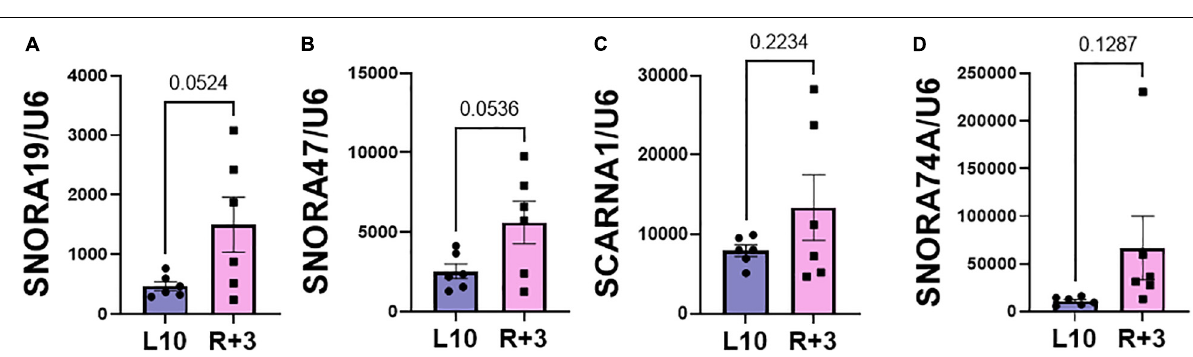
FIGURE 2 | Validation of PBMC snoRNA by RT-qPCR. Validation of differentially expressed snoRNAs in the RNA from PB mononuclear cells (PBMCs) collected L-10 and R + 3 from six astronauts by RT-qPCR, normalized to U6 snRNA ( n = 6 astronauts/group), including (A) SNORA19, (B) SNORA47, (C) SCARNA1, (D) SNORA74A. Data are presented as mean ± SEM vs. L-10 (two-sided unpaired students t